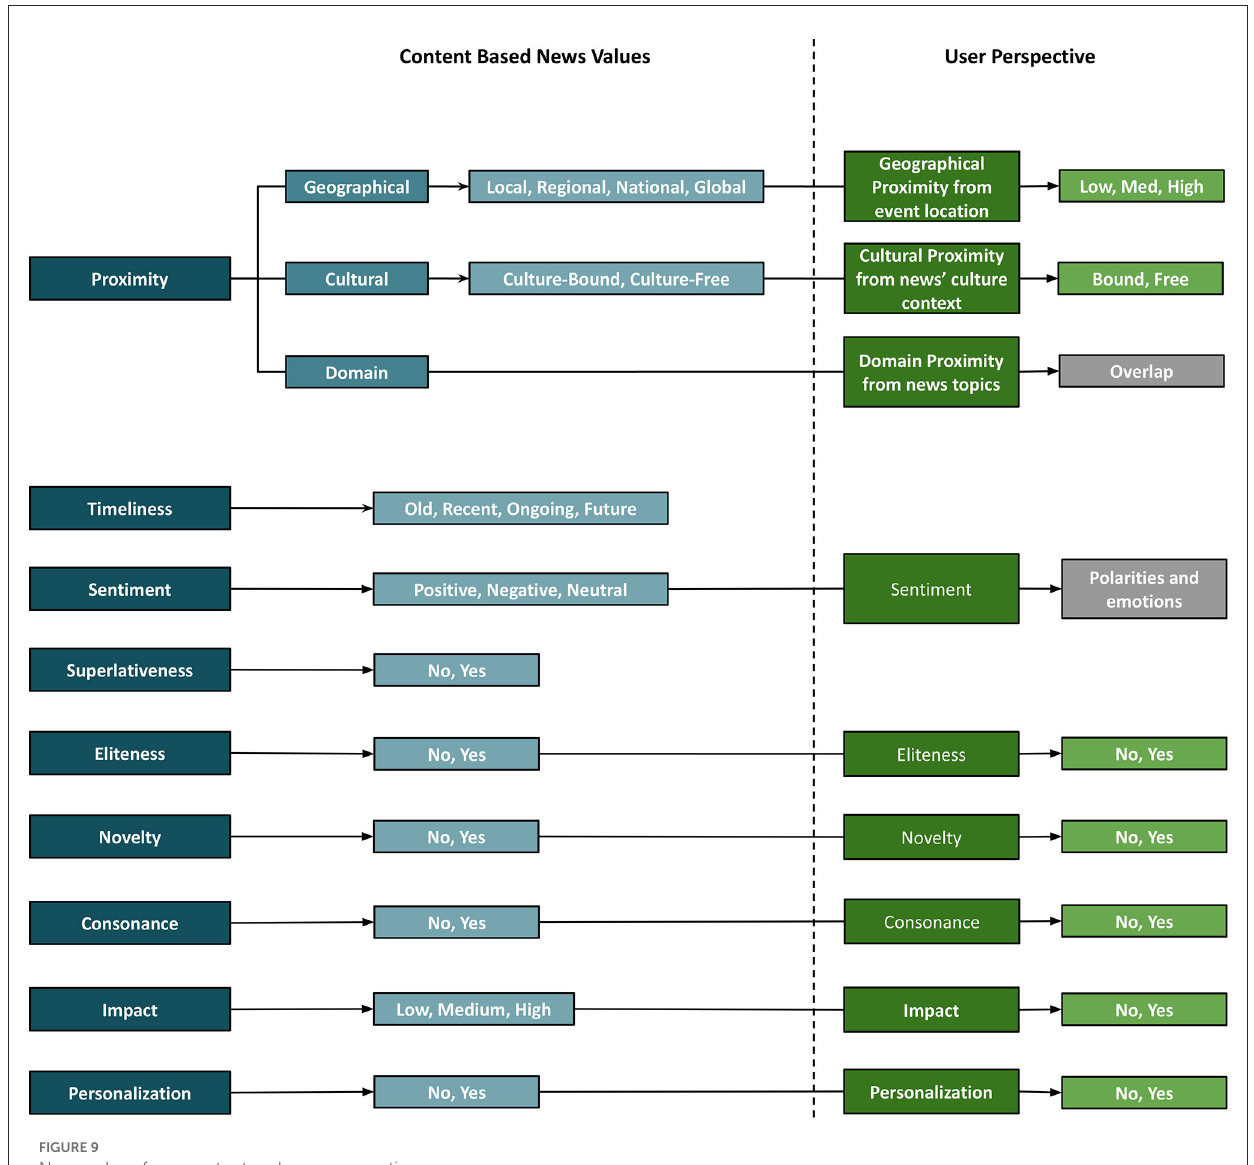
FIGURE9 News values from content and user